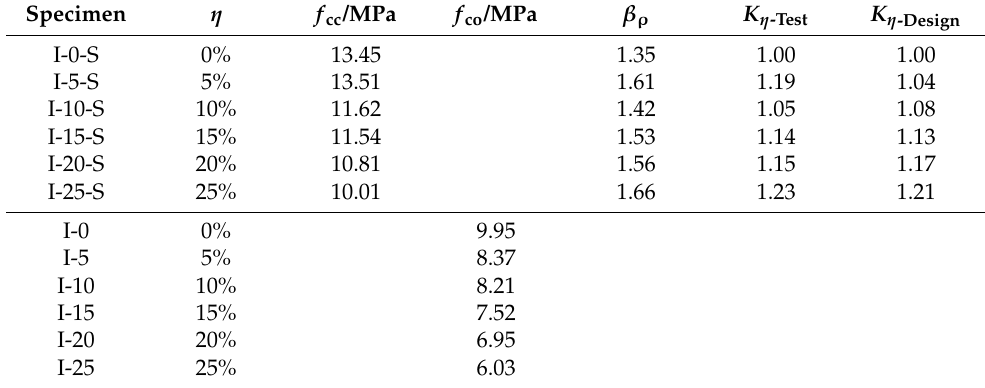
Table 7. Compressive strength of core concrete of tested